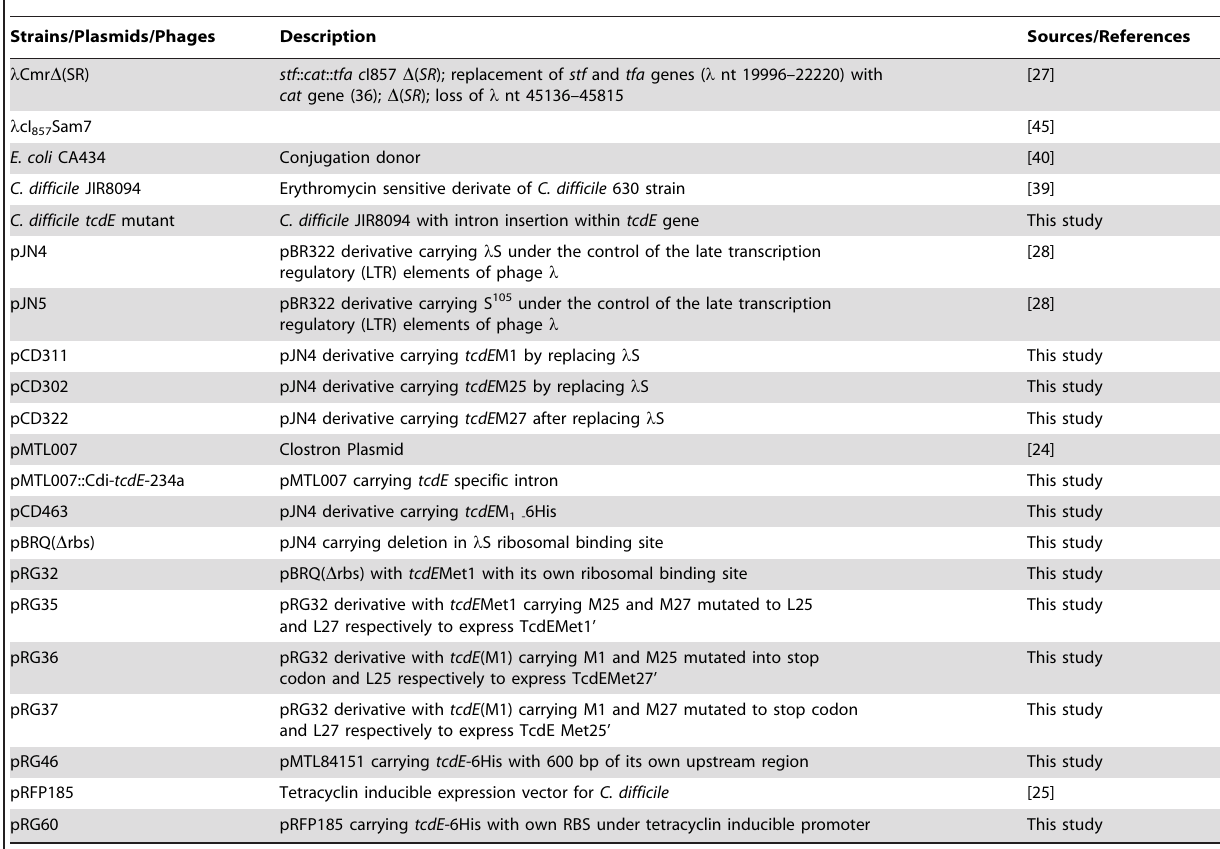
Table 1. Bacterial strains, plasmids and phages used in this